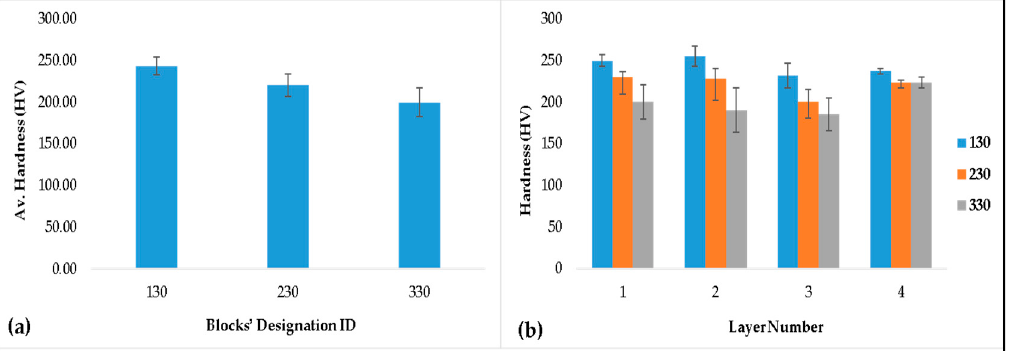
Figure 8. Bar charts displaying the hardness values. ( a ) Average values and ( b ) layer-by-layer values for the 130, 230, and 330 built blocks.